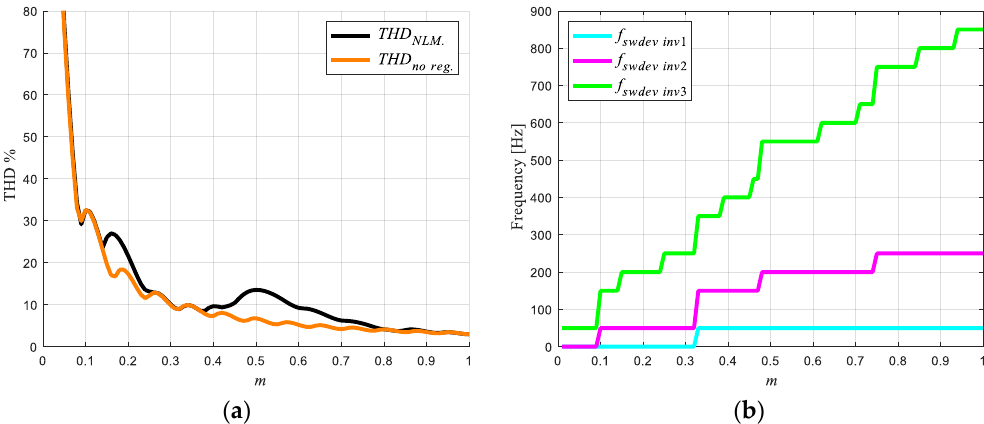
Figure 5. ( a ) Comparison THD output voltage, comparison between NLM and no regenerative modulation technique [22] ( b ) Switching frequency distribution by semiconductor device.